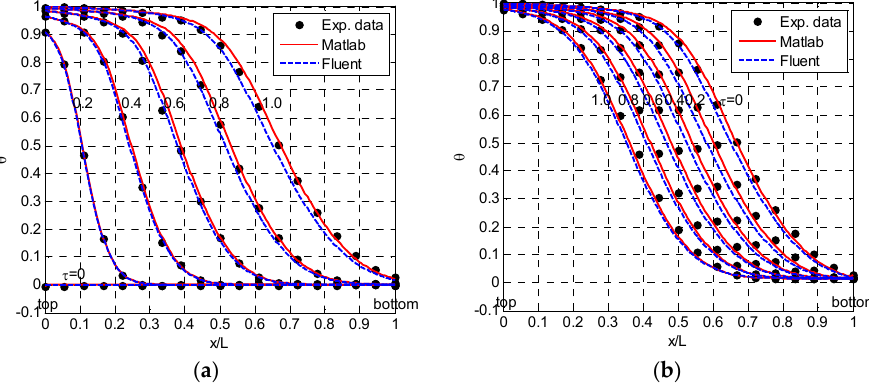
Figure 3. ( a ) Axial temperature distribution at the mass flow rate of 0.15 kg/s during charging phase ( τ = 1 for 4705 s); ( b ) Axial temperature distribution at the mass flow rate of 0.15 kg/s during discharging phase ( τ = 1 for 1995 s).